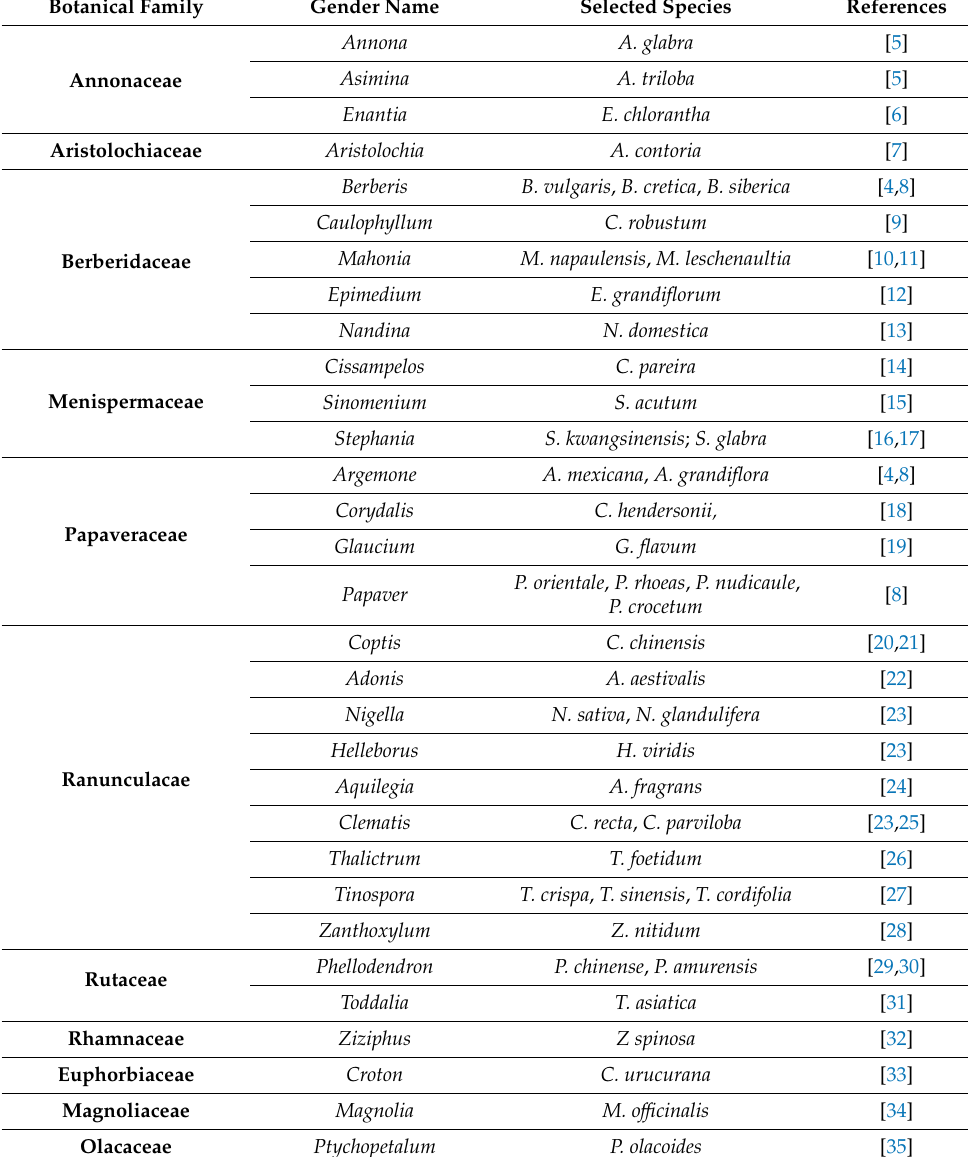
Figure 1. Chemical structure of ( + )-(S)-magnoflorine ( α -magnoflorine) . Table 1. The distribution of magnoflorine among plant species.